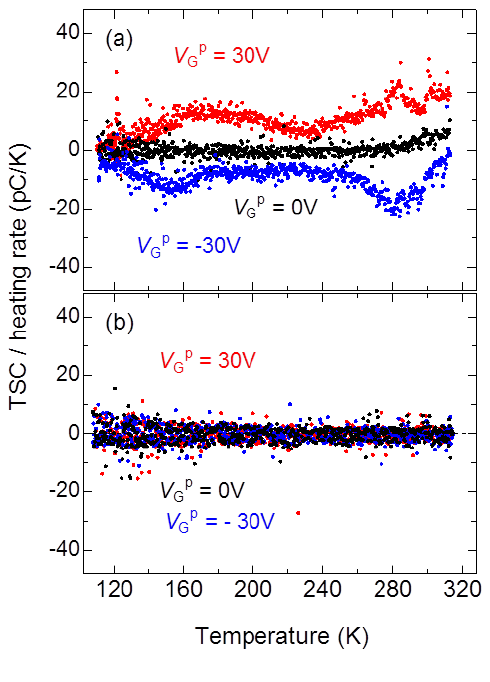
Figure 3. ( a ) Gate-induced TSCs observed in the FET sample after various V p TSCs observed in the substrate without (BEDT-TTF)(TCNQ)